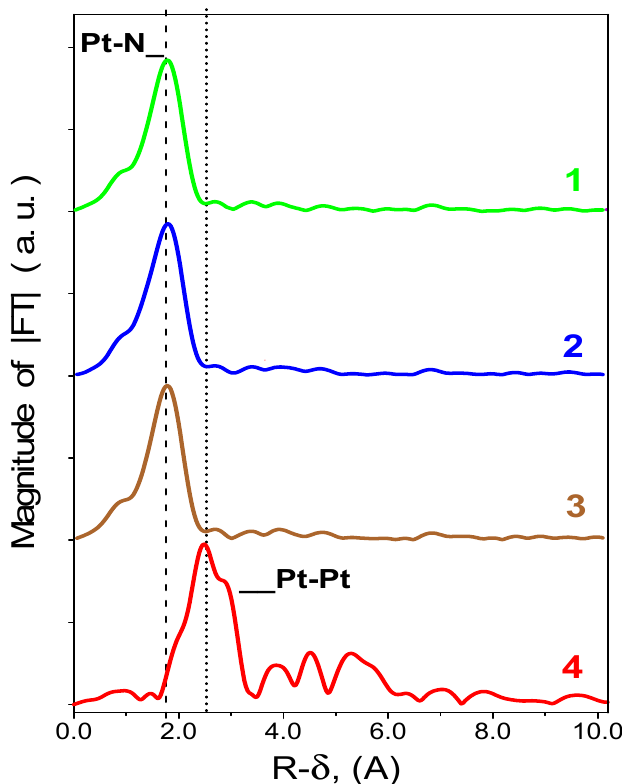
Figure 8. RDF curves of atoms of the platinum local arrangement in 0.2% Pt/N-graphene (H 2 PtCl 6 ) (1); 0.4% Pt/N-graphene (H 2 PtCl 6 ) (2); 1.0% Pt/N-graphene (H 2 PtCl 6 ) (3); Pt-foil*0.5 (4).